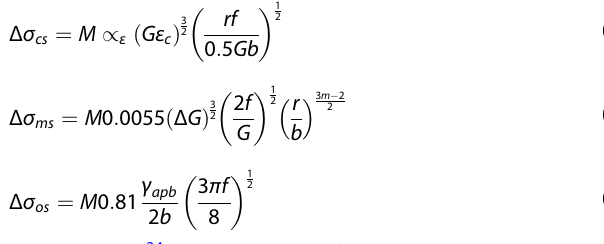
2 μ m in the aluminum alloy are the starting points of crack initiation 33 , reducing the ductility of the material, and thus the reduction of the micron-level residual secondary phase is conducive to an improvement in ductility. Therefore, the three- stage solution treatment simultaneously bene fi ts the strength and ductility of the alloy. The precipitation strengthening caused by aging precipitate hindering dislocation movement is controlled by the mechanism with less hindering effect in the dislocation bypassing mechanism and shearing mechanism. When the precipitation strengthening is dominated by the bypassing mechanism, the strength increment Δσ 32 . orowan can be calculated by Eq. (1)